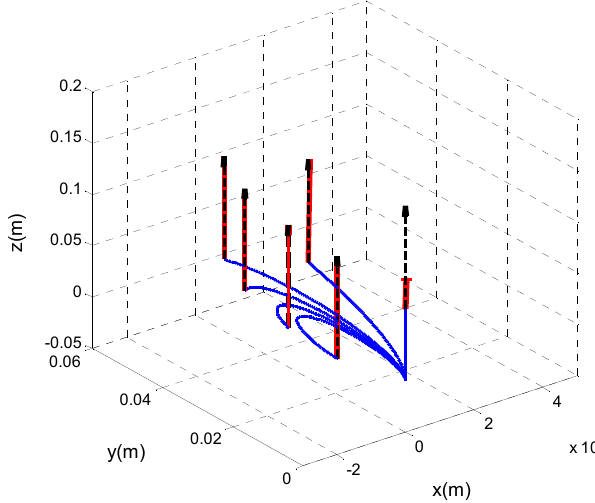
Figure 5. Contact force estimates of the applied forces on the distal tip with the initial curvatures of the distal shaft, k 1,0 , ranging from 0–60 m − 1 . The distal shaft of the catheter is represented in blue, the IEKF-based force estimates are sketched with red arrows, whereas the true values are depicted by black dashed counterparts and are defined in (N).